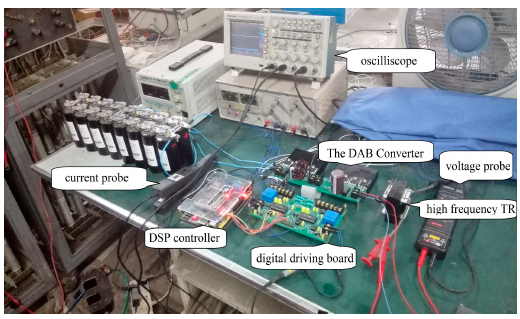
Figure 18. The experimental prototype diagram.